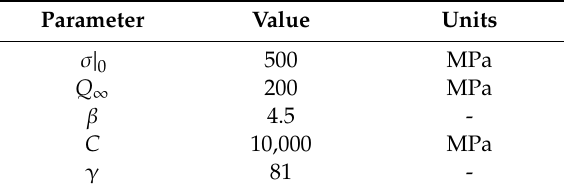
Table 2. Determination of the parameters in the combined hardening rule.